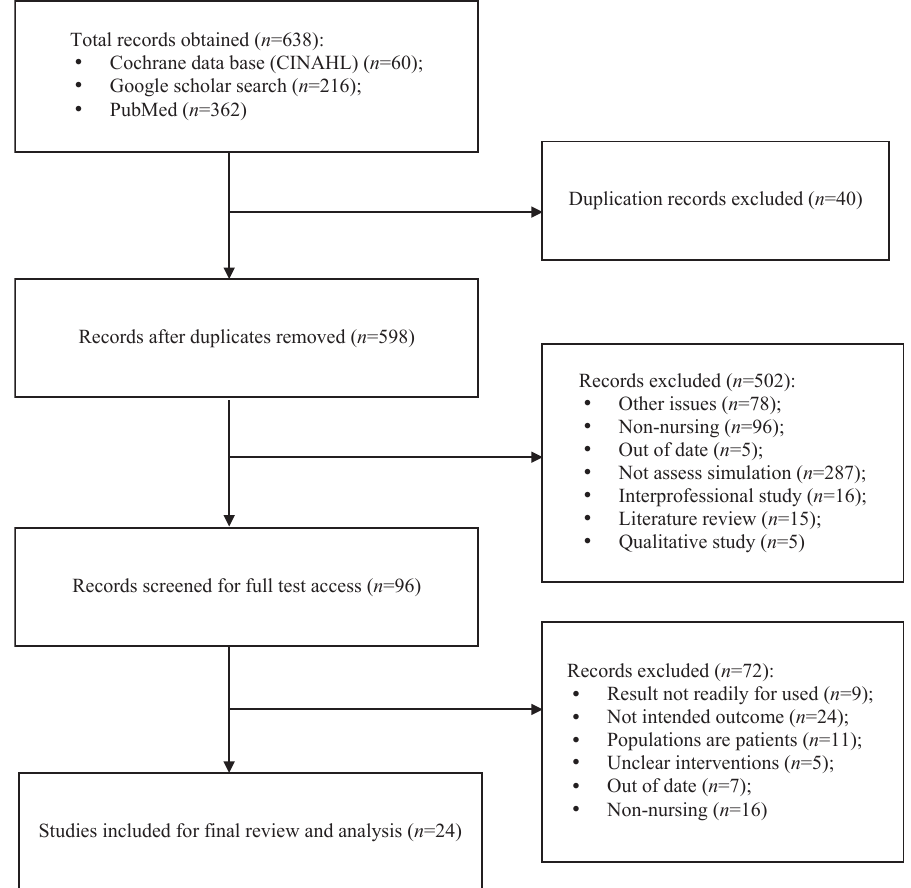
Figure 1. Flow diagram showing the process of study identification and